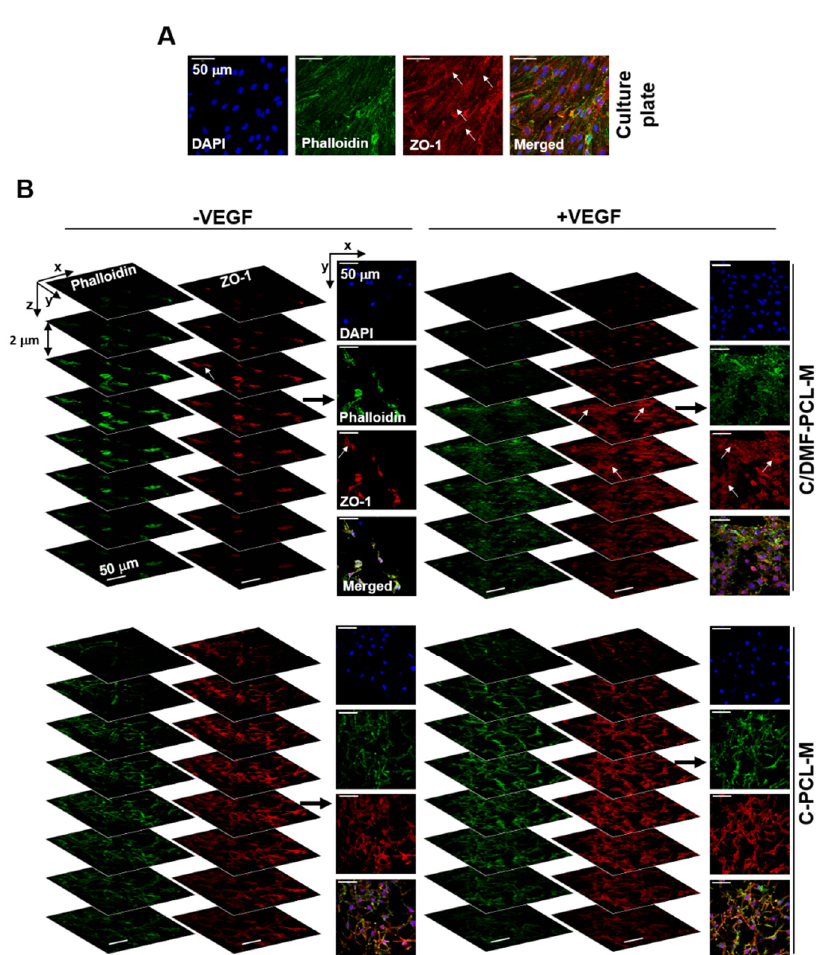
Figure 7. ZO-1 expression in bEND.3 ECs cultured on a culture plate and nanofibrous membrane scaffold. bEND.3 ECs (3 × 10 4 ) were cultured for 5 d on a culture plate ( A ) and C/DMF-PCL-M or C-PCL-M in the presence ( + VEGF) or absence ( − VEGF) of VEGF ( B ) ( n = 3). The formation of tight junctions between the cells (arrows) was evaluated using confocal microscopy after the cells were stained using anti-ZO-1 antibody (red). In panel B, the localization of tight functions was evaluated by focus-stacking images of ZO-1 expression in the cells. The data represent three independent experiments.